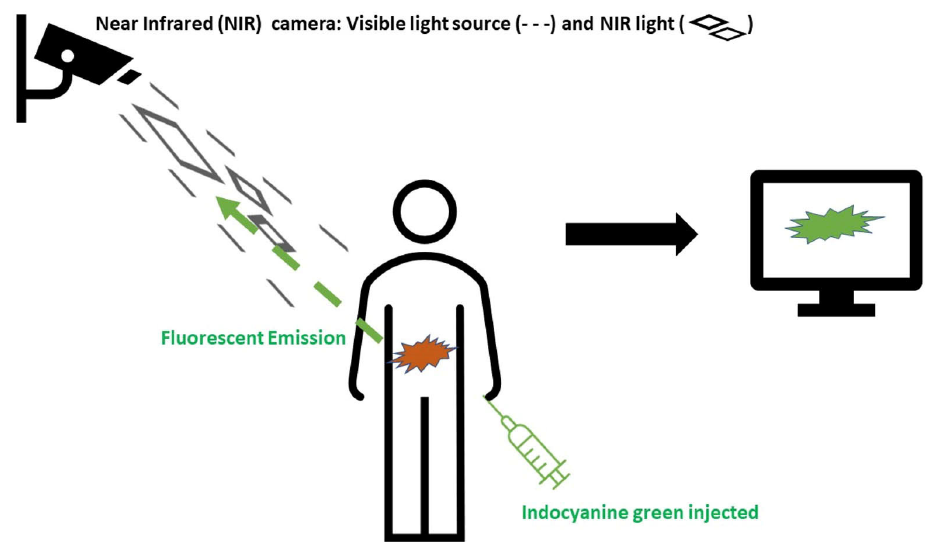
Figure 1. The basics of indocyanine green (ICG) imaging in colorectal surgery. ICG is injected (method of administration varies depending on the target). The ICG molecules are excited by the light source and demonstrate fluorescent properties in the near-infrared spectrum (750–950 nm). This signal is combined with real time image and transferred on the